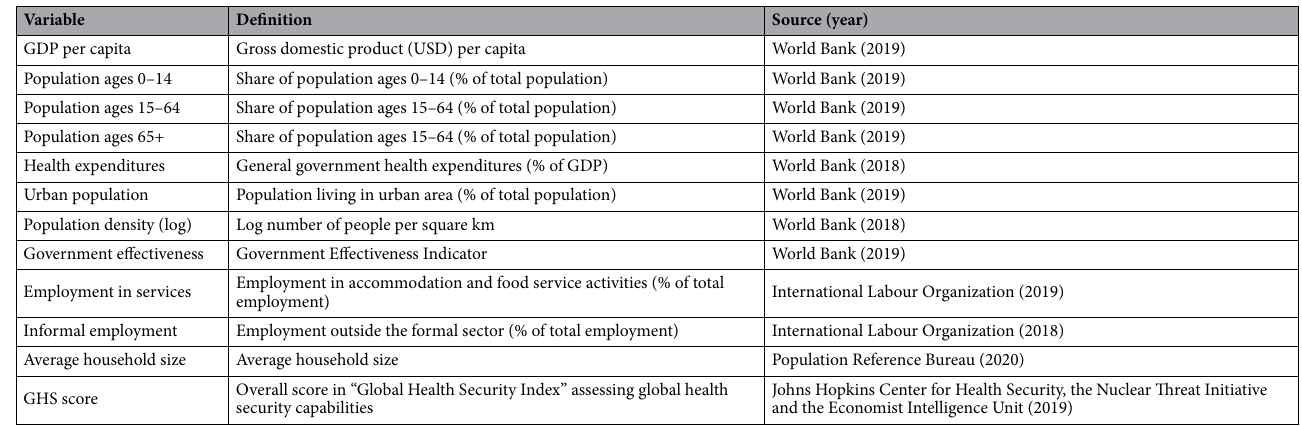
Table 1. List of country characteristics. GDP: gross domestic product; GHS: global health security.